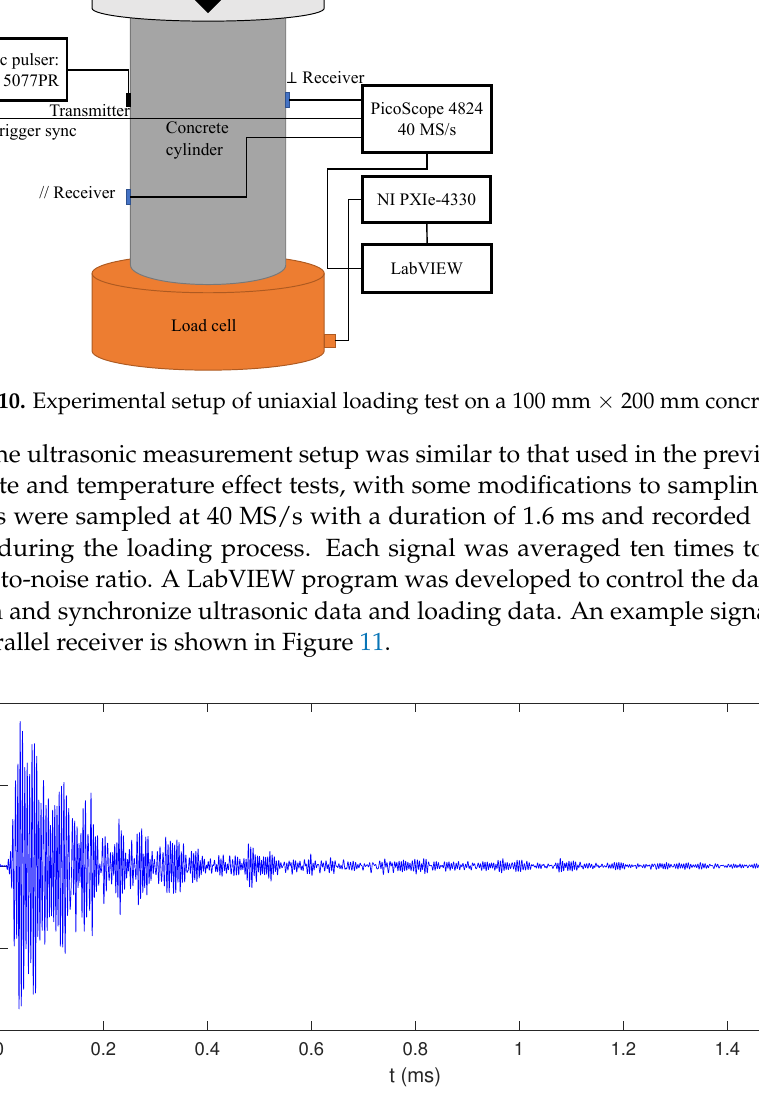
Figure 11. A typical ultrasonic signal received by the parallel